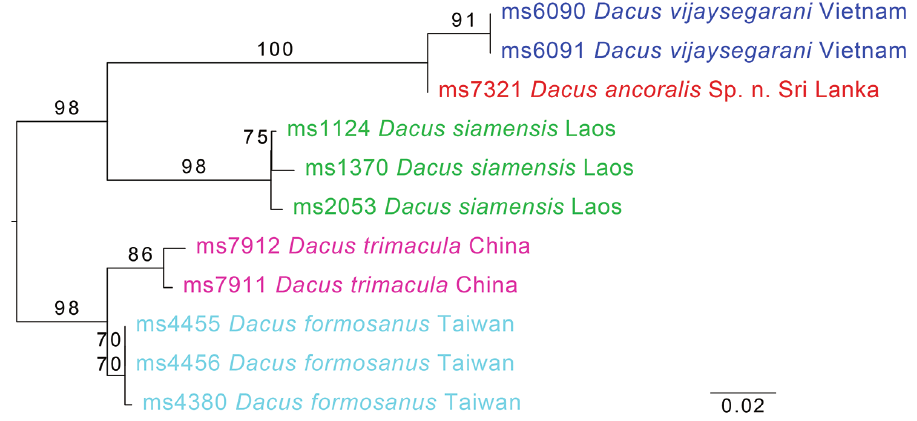
Figure 3. Maximum likelihood tree based on COI (1535 base-pairs) sequence data. Bootstrap support is indicated on the respective branches. Scale bar indicates substitutions per